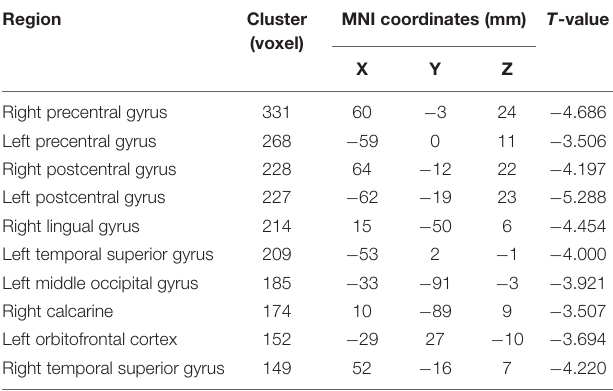
TABLE 2 | Brain regions with decreased fALFF values in patients with FES compared with healthy controls (SCZ < HC). Region Cluster MNI coordinates (mm) T -value (voxel)